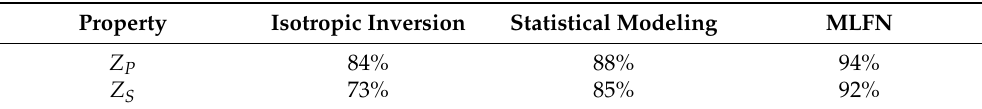
Figure 18. The histogram plots of the zero-offset P-impedance obtained from ( a ) isotropic inversion, ( b ) statistical modeling, and ( c ) MLFN. Table 2. The correlation coefficients of the predicted Z P and Z S obtained from isotropic inversion, statistical modeling, and MLFN at the wells ( × 1) and ( ×